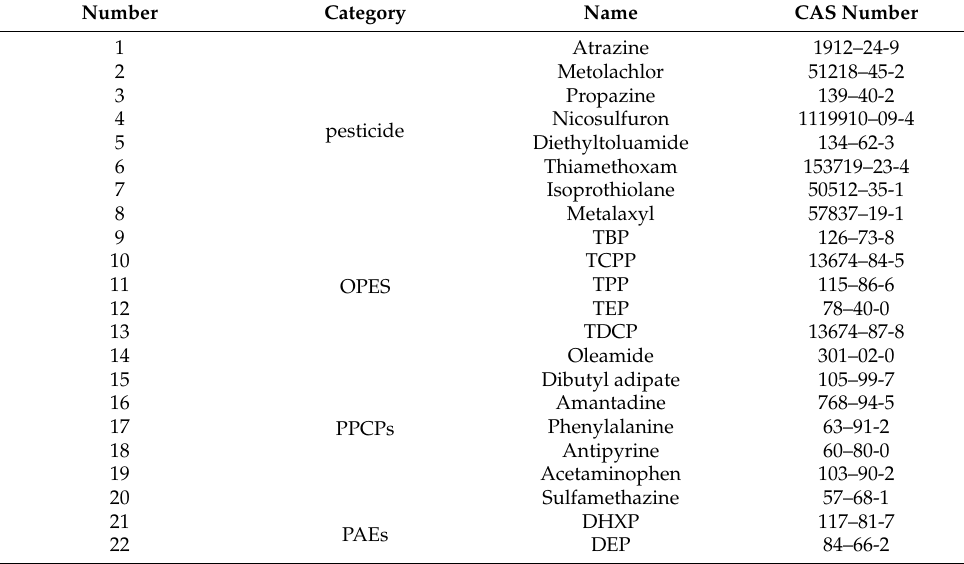
Table 3. The list of organic pollutants required to be